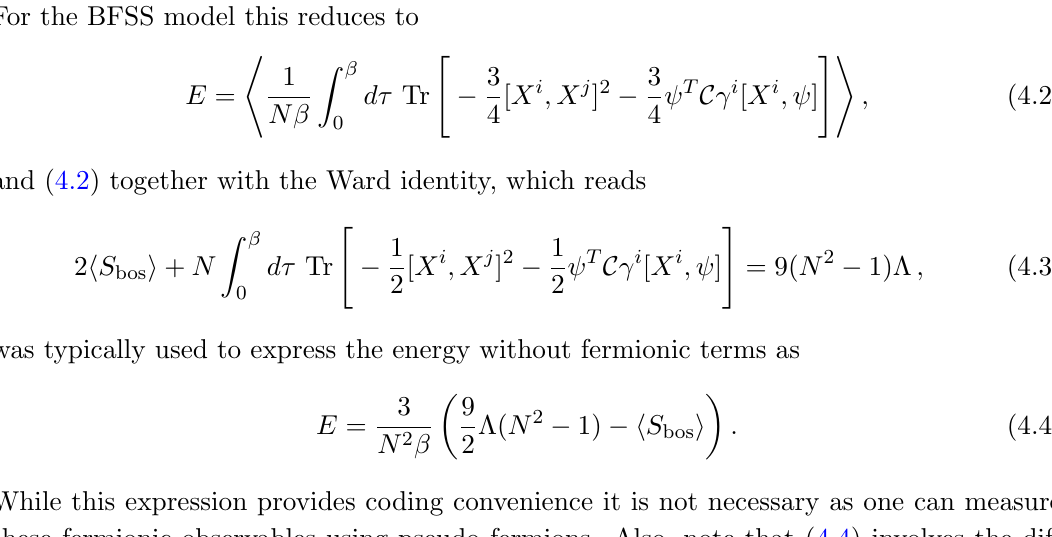
Figure 3 . The (cid:12)gure shows the Myers observable, the energy as a function of temperature, the R 2 for each X i as a function of Monte Carlo sweep and the spectrum of the holonomy (cid:26) for (cid:22) = 2 : 0, N = 8, (cid:3) = 24. The red vertical line shows our measured value of the transition temperature T c = 0 : 345. One can see that the two transitions have merged to a single transition for this value of (cid:22) . Since the mass is relatively small we have also included, in the energy plot, the energy of the BFSS system for (cid:22) = 0, N = 24, (cid:3) = 24 (the purple